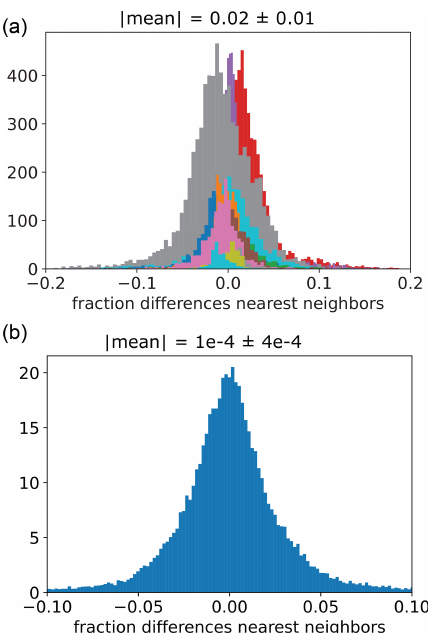
Figure 13. (a) Histogram of the fractional differences between near- est neighbors sites in the Houston network with the temperature cor- rection applied using the network median as a reference. Different colors represent different pairs of neighboring sites. The mean in- dicated is the average of the absolute values of each neighboring pair’s mean fractional difference. The error is the associated 95% confidence interval. (b) Histogram of the fractional differences be- tween all aggregated nearest neighbors sites with the temperature correction applied. The mean and error indicated are the mean and 95% confidence interval, respectively, of the